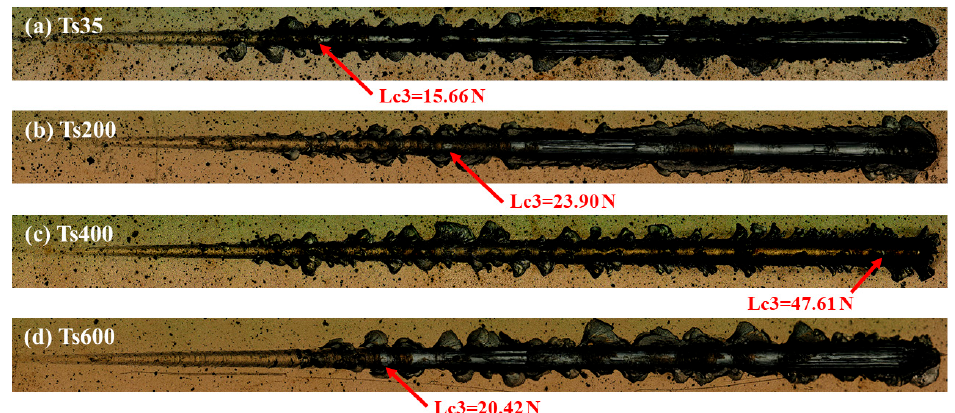
Figure 10. Adhesion of TiN coatings under different substrate temperatures: ( a ) Ts35; ( b ) Ts200; ( c ) Ts400; ( d ) Ts600. ( c ) Ts400; ( d ) Ts600.